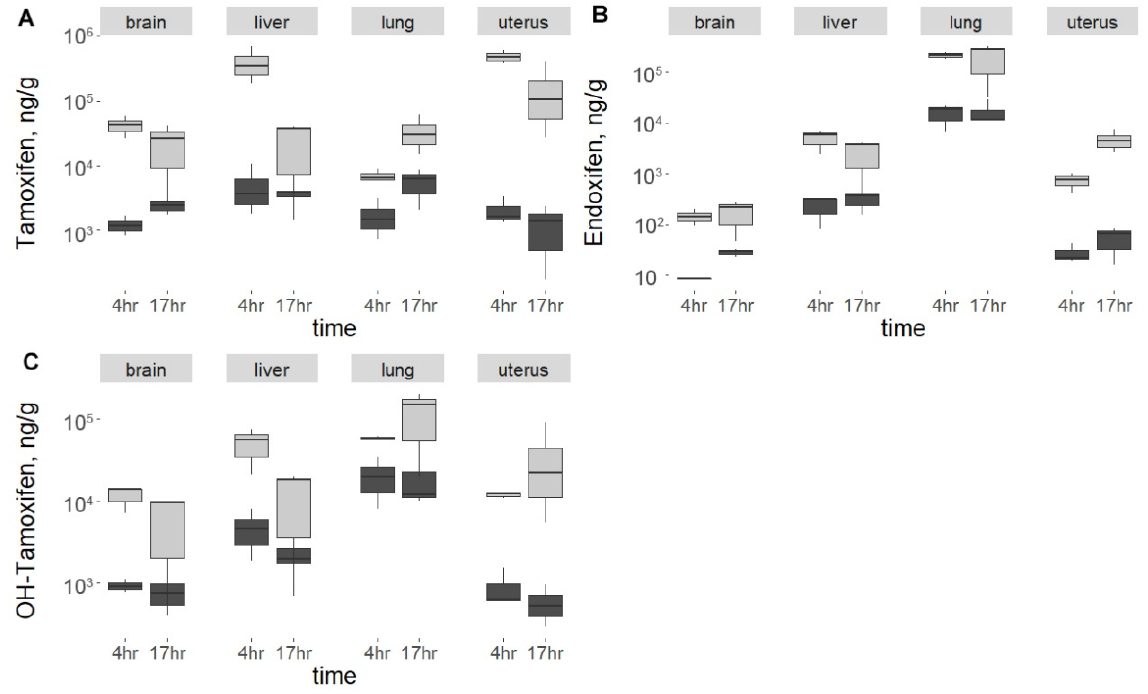
Figure 4. Tamoxifen ( A ) and its metabolites ( B , C ) concentrations in organs in exponential scale. Pale ( □ ) boxes represent injection method, while feeding method samples are shown dark ( ■ ). Table 1. Ratios of mean organ metabolite concentration in injected and fed sample groups.